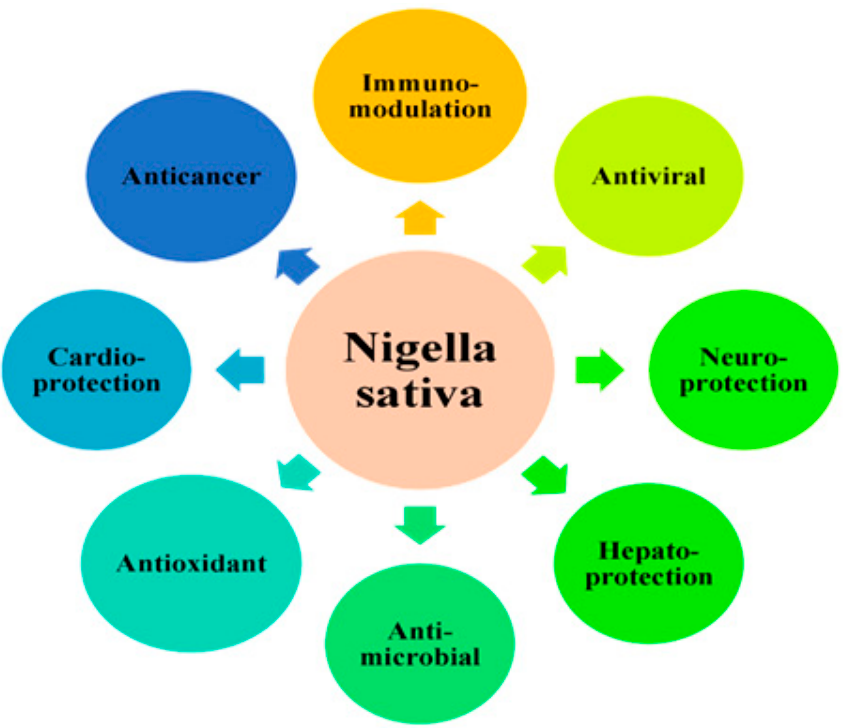
Figure 3. Medicinal properties of Nigella sativa .